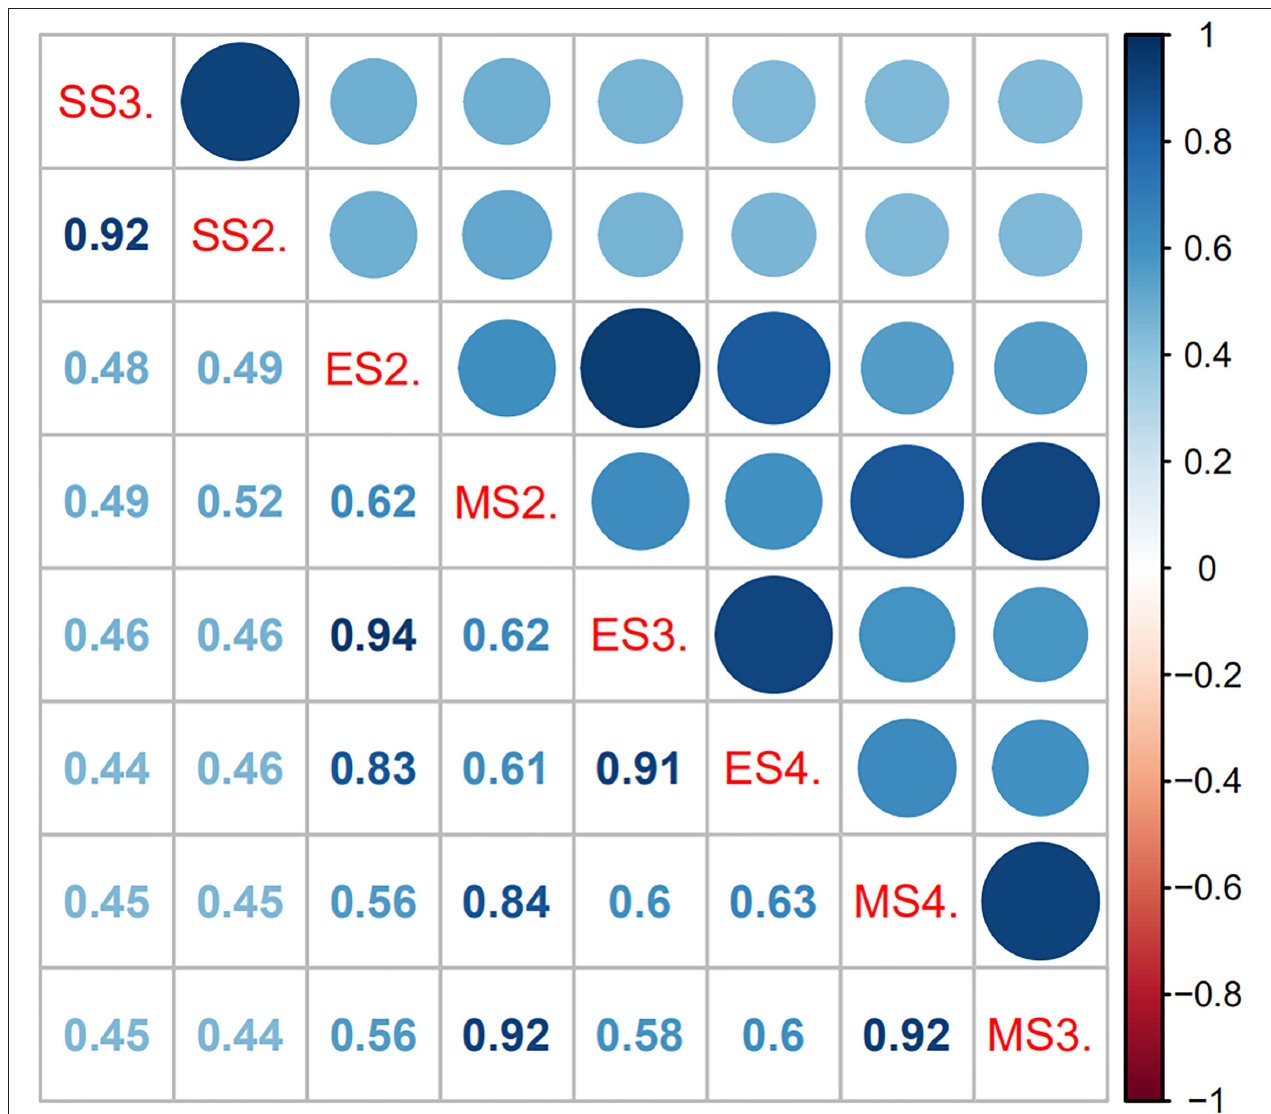
FIGURE 3 | Pearson’s correlation matrix for leaf angle in sugarcane different growth stages. The shaded scale refers to the strength of correlation. In Pearson’s correlation, abs r = 0.5–1 means a greater correlation, abs r = 0.3–0.5 means medium correlation, abs r = 0.1–0.3 means lesser correlation, and abs r = 0–0.1 means no correlation. SS2. and SS3. denote the + 2 and + 3 leaf of the sugarcane seedling stage, respectively; ES2., ES3., and ES3. denote the + 2, + 3, and + 4 leaf of the sugarcane elongation stage, respectively; MS2., MS3., and MS4. denote the + 2, + 3, and + 4 leaf of the sugarcane mature stage,